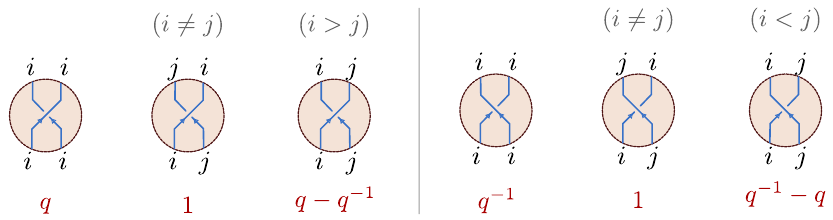
Figure 29 . Weights for labeled crossings. Left: overcrossing. Right: undercrossing. The weight β ( ‘, c ) for each labeled crossing is shown in red. For labeled crossings which are not of any of the types shown, the weight β ( ‘, c ) = 0